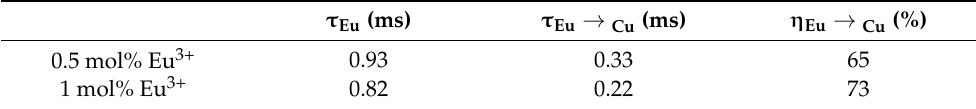
Table 2. The average lifetime of Eu 3+ -doped ( τ Eu ), Eu 3+ /1 mol% Cu 2+ ( τ Eu → Cu )